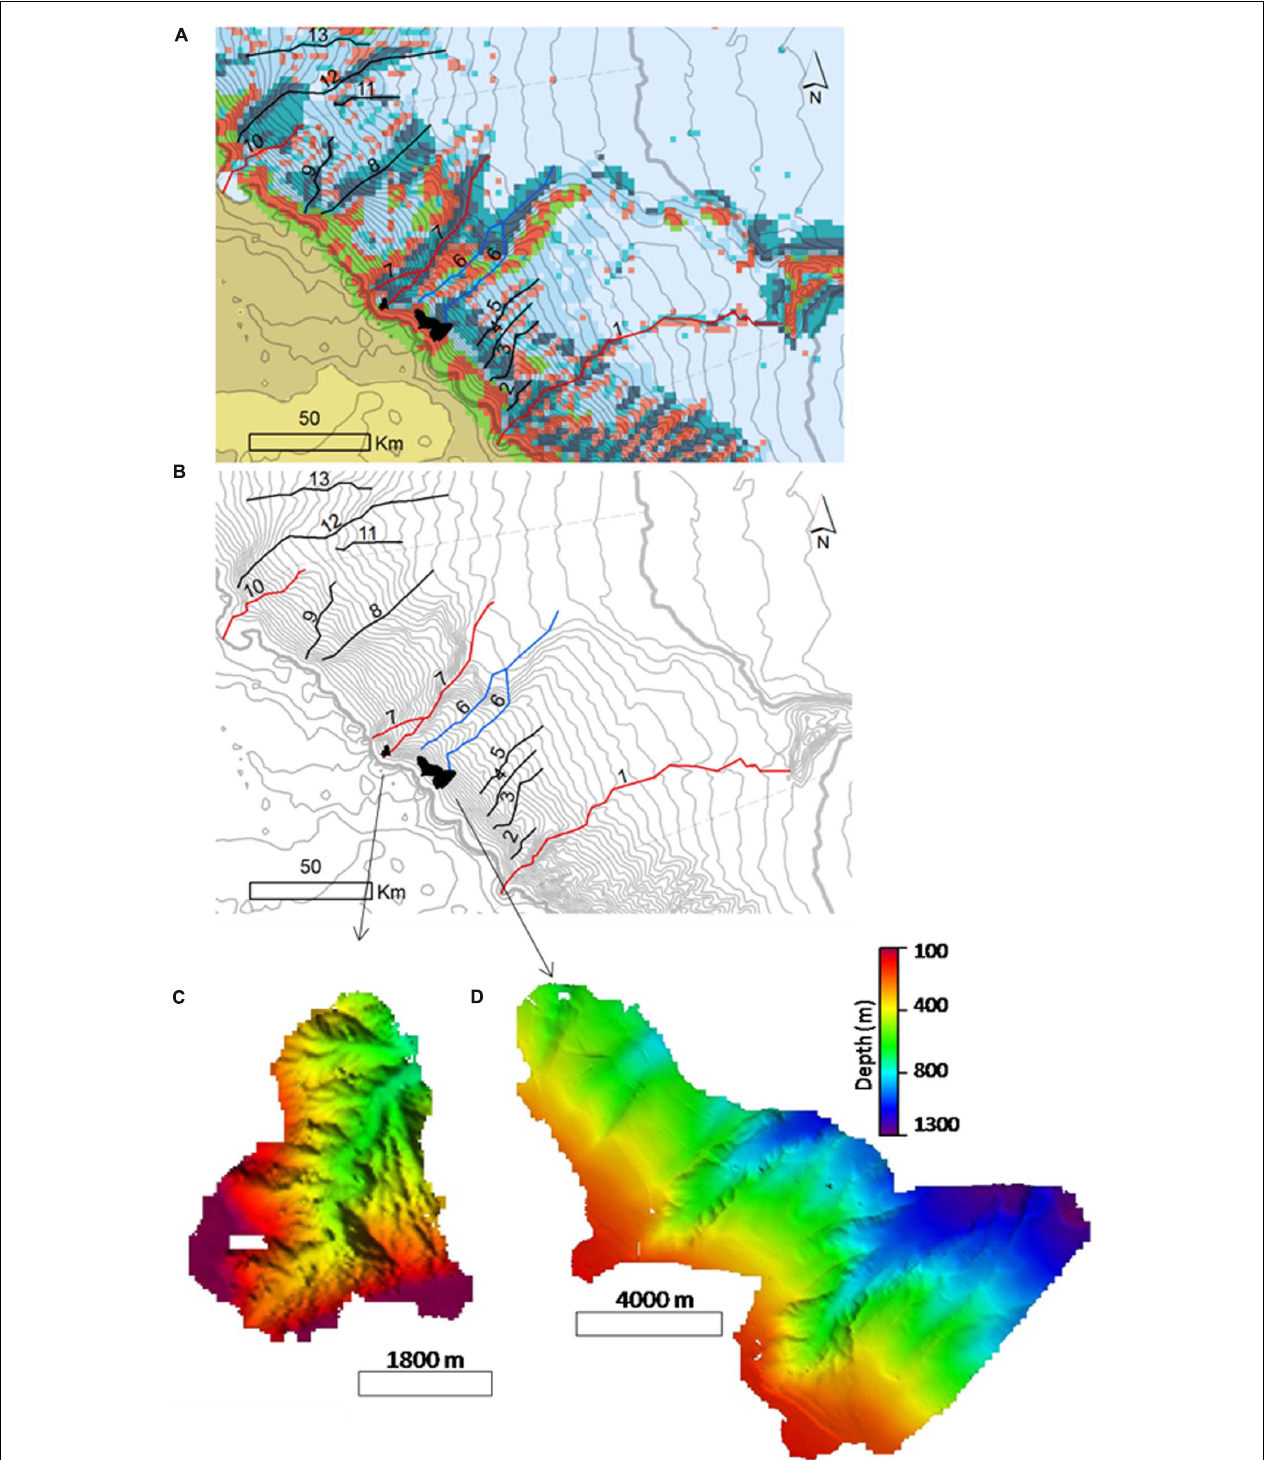
FIGURE 5 | Continental slope depressions in sector S1. Mapping procedures followed the combined methods of delineation by BTM seabed classes thalweg 1 and 2 (A) , and the DTM with isobaths spacing each 100-m water depth interval (B) . Depression types are distinguished by colors: (1) depressions not classified as canyons and confined at the continental shelf (black lines), (2) slope confined canyons (blue lines), and (3) canyons that incise the continental shelf (red lines). Arrows (B,C) show the location of a 40-m resolution multibeam mapped area with examples of canyons incising on the continental shelf (C) and canyons confined at the slope (D) . Vertical exaggeration